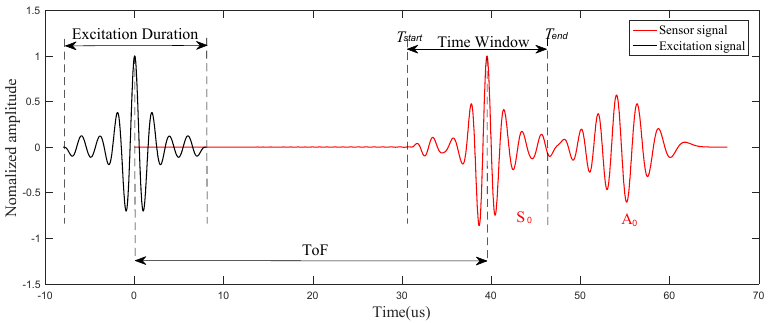
Figure 9. Schematic illustration for the time window calculation (300~700 kHz L-Chip).